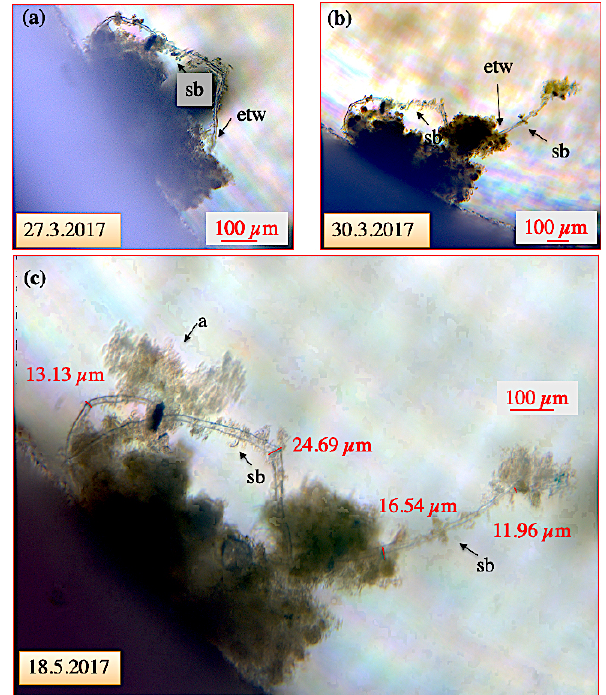
Figure 7. Ectoplasmic twigs of C. pachyderma specimen 8. (a) For 3d, the specimen had gathered algal detritus around its shell en- velope and simultaneously developed a loop-like ectoplasmic twig with a total length of ∼ 700µm from the periphery to the oppo- site side. (b) Three days later, an ∼ 500µm measuring extension directing into the water column was added to the loop-like twig. Both structures persisted for the remaining weeks of the experiment. (c) On 15 May, dispersion of algae into the aquarium allowed the specimen to collect additional algae onto the ectoplasmic twig. The algae mass remained in this position and was not ingested during the experiment. “etw” denotes ectoplasmic twig; “a” denotes algae; “sb” denotes side